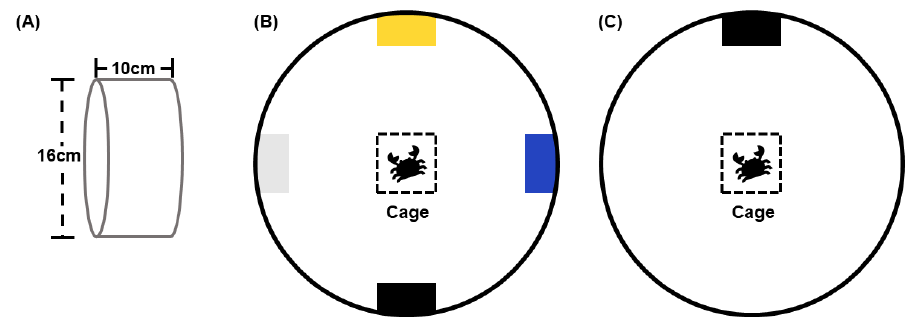
Figure 2. The circular shelter ( A ), a vertical view of the experimental aquarium with different colored shelters ( B ), and a vertical view of the experimental aquarium with one colored shelter ( C ).